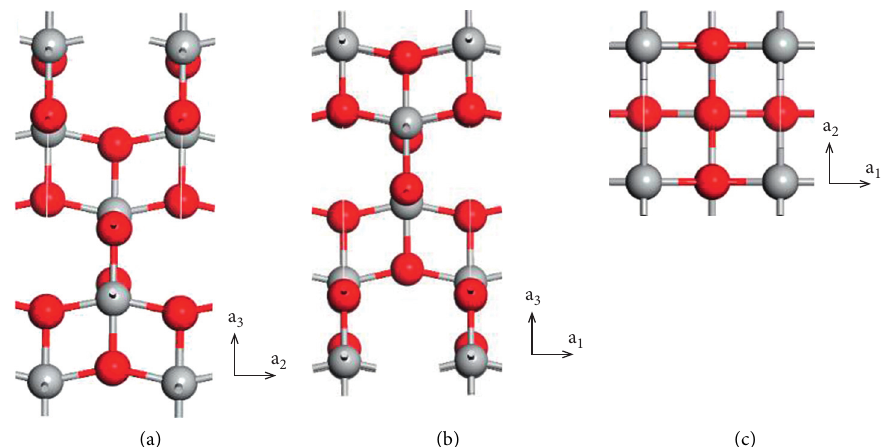
Figure 2: Projections on to (100) plane (a), (010) plane (b), and (001) plane (c) for anatase TiO and the gray sphere represents titanium.